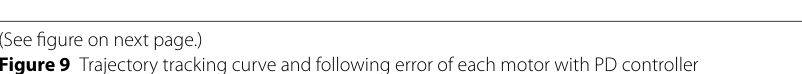
(See figure on next page.) Figure 9 Trajectory tracking curve and following error of each motor with PD